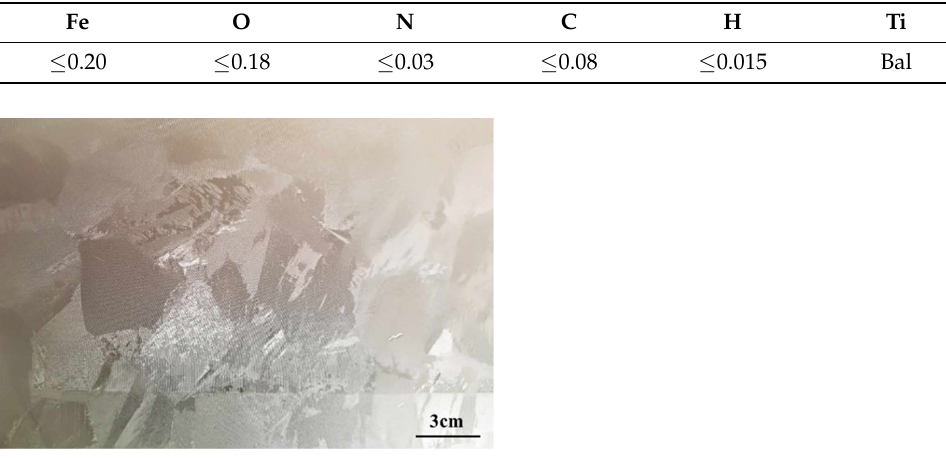
Figure 1. Original structure of slab directly melted and cast in EB furnace. The heat treatment temperatures of the sample were selected at 700 ◦ C, 750 ◦ C, 800 ◦ C, 850 ◦ C, and 900 ◦ C, according to the thermal simulation compression deformation